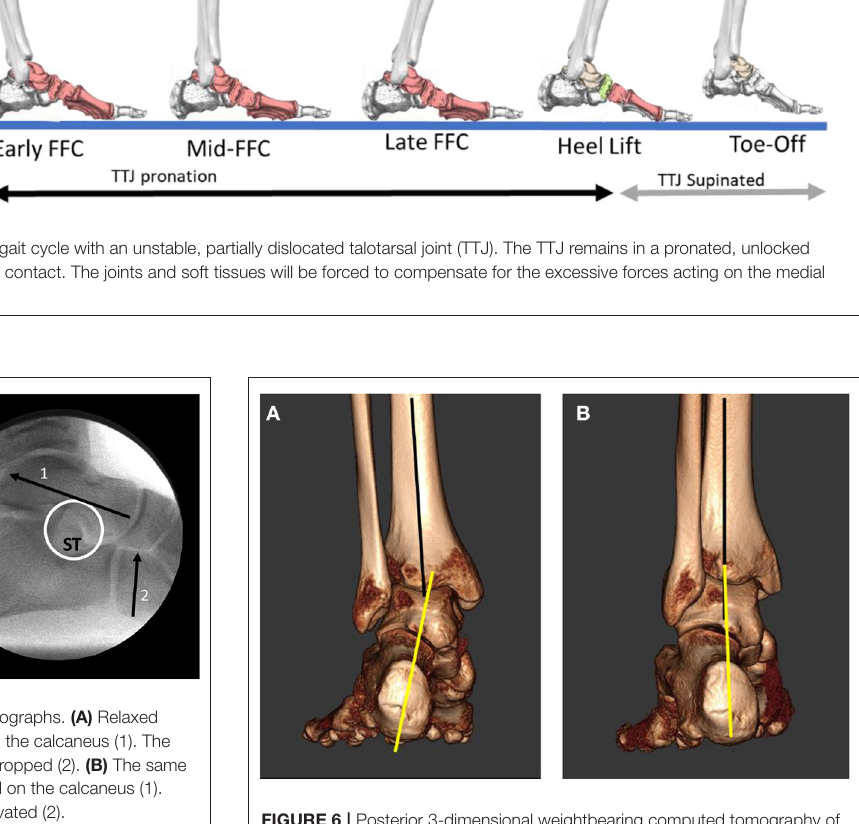
the hindfoot. (A) Hindfoot is in relaxed-stance position, notice the heel valgus (yellow line). (B) Same foot with the subtalar joint placed into neutral alignment, notice the rectus heel alignment.